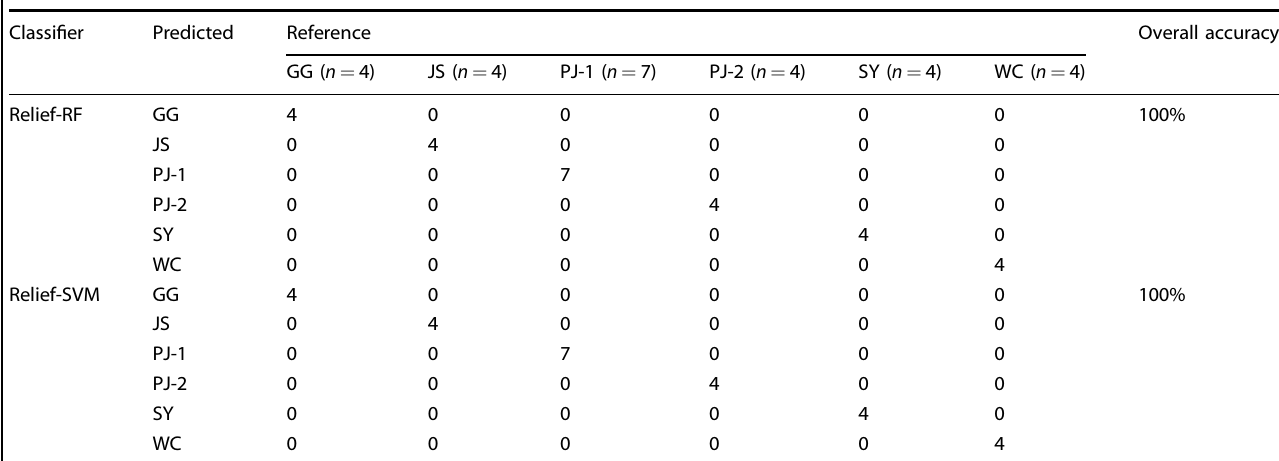
Table 1. Confusion matrix for the independent validation using the testing